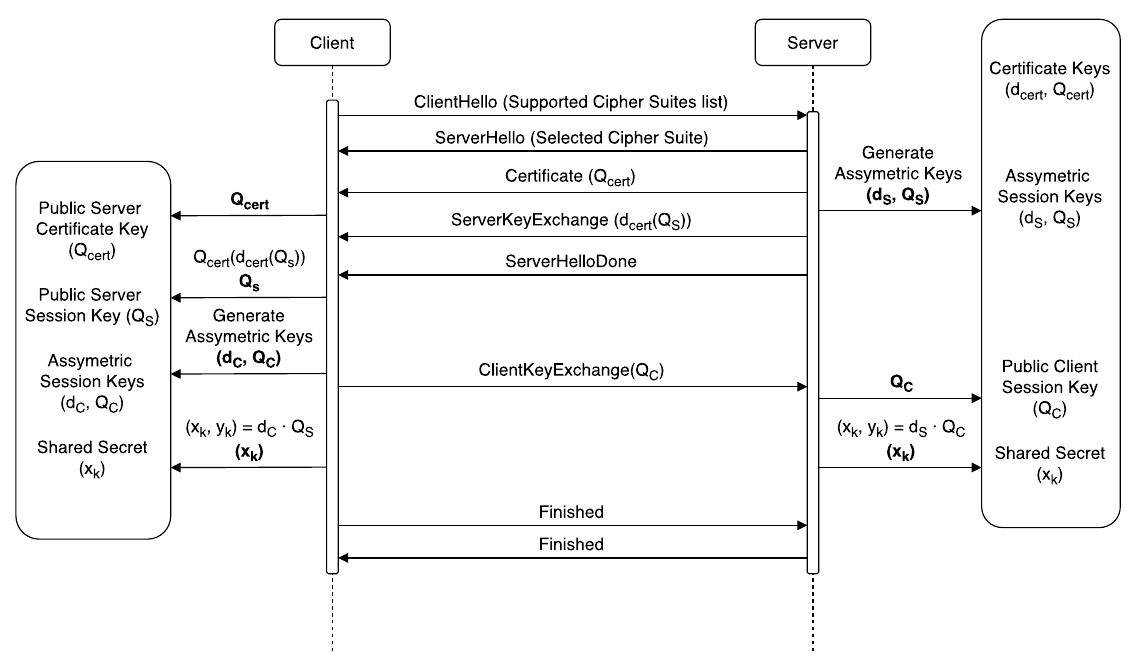
Figure 11. TLS Handshake procedure for ECDHE-ECDSA-AES256-GCM-SHA384 and similar cipher suites [29].